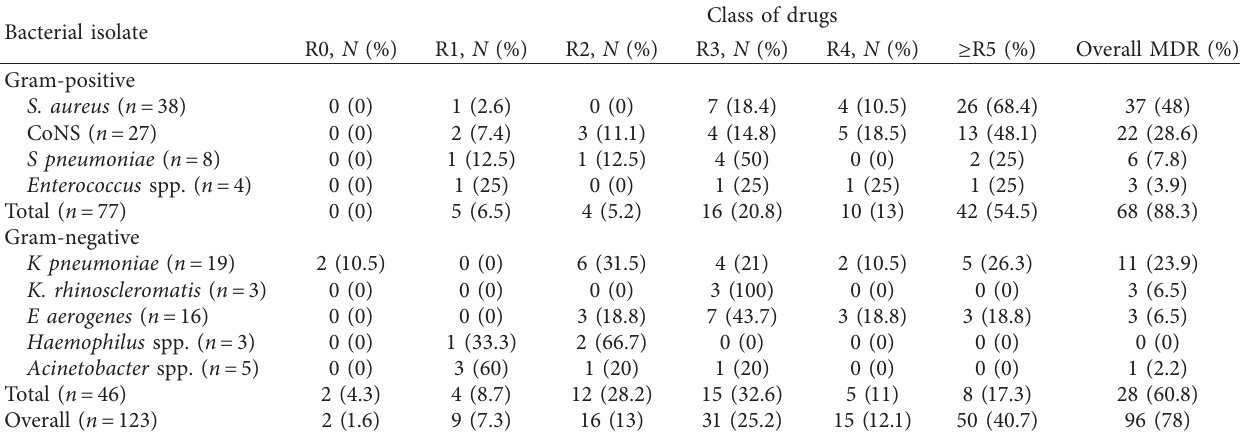
Table 5: Multidrug-resistant patters of the bacterial isolates among blood culture-positive HIV/AIDS patients at Felege Hiwot Referral Hospital.